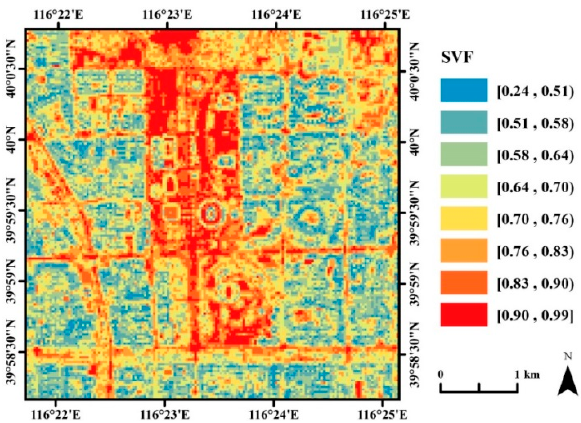
Figure 3. Spatial distribution of the sky view factor (SVF) in the study area.